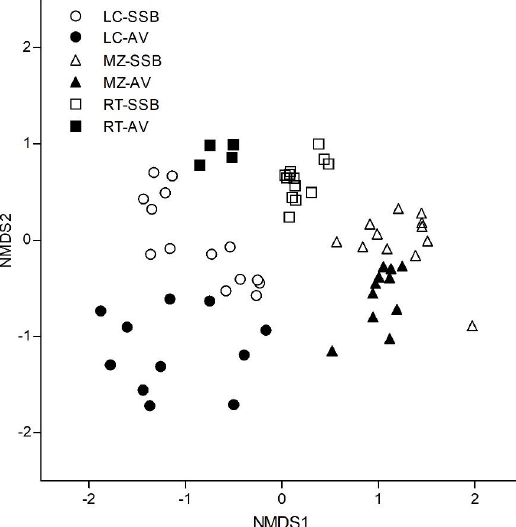
Figure 7. Two-dimensional non-metric multidimensional scaling (NMDS, stress = 0.0946) ordination of above-ground vegetation (AV) and soil seed bank (SSB) for sites (LC, MZ and RT). Ordination is based on species presence, using Sorensen ’ s distance.